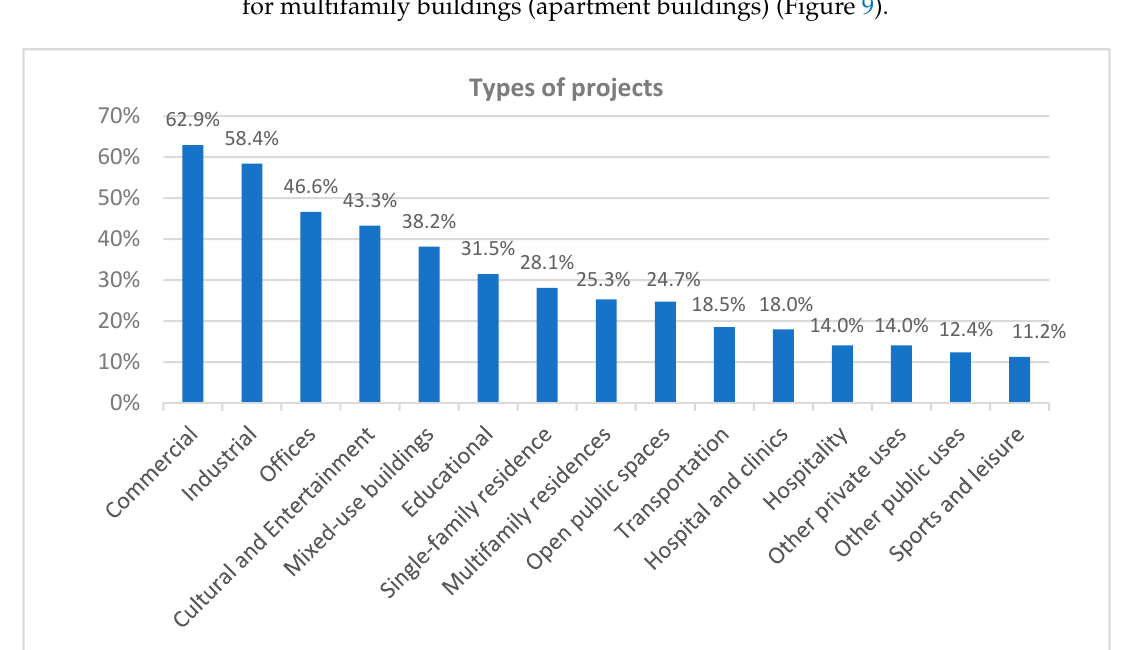
Figure 9. Types of scan-to-BIM projects worked in the last 12 months.